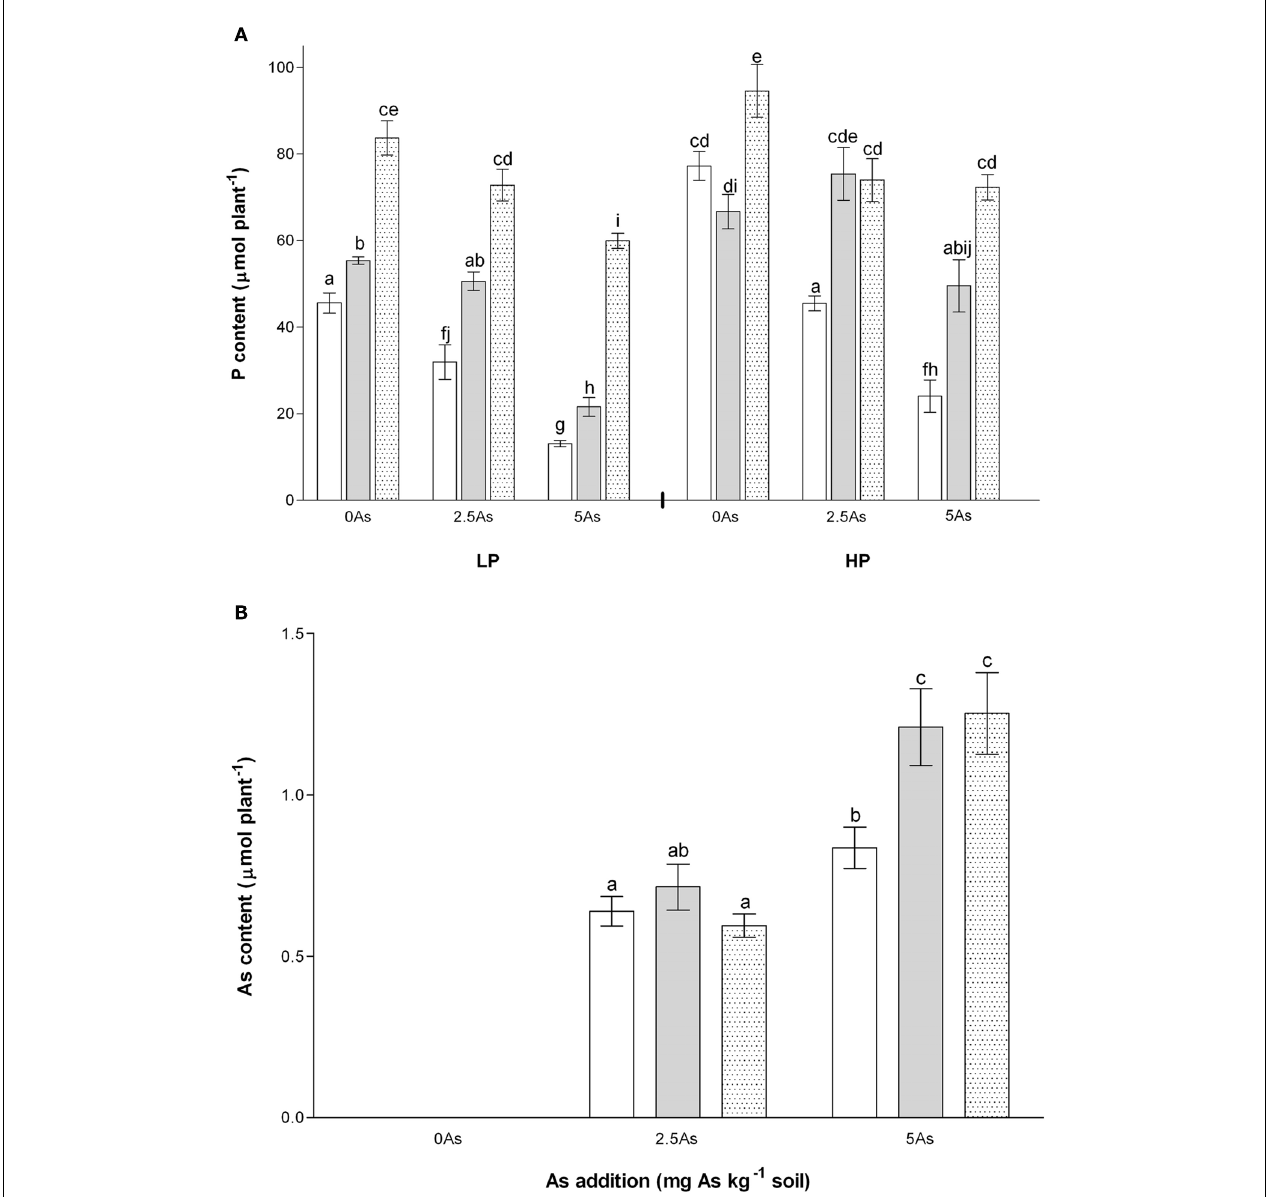
treatment group NM, HP5As where n = 3; n = 10 in (B) except in treatment group NM, 5 As where n = 8]. In (A) , the interaction between all factors (P, As, and inoculation) was significant ( P = 0.005). In (B) no As was detectable in plants grown in the absence of As.The interaction between inoculation and As application was significant ( P = 0.006). In each graph the same letters indicate no significant difference between treatment groups at the 5%